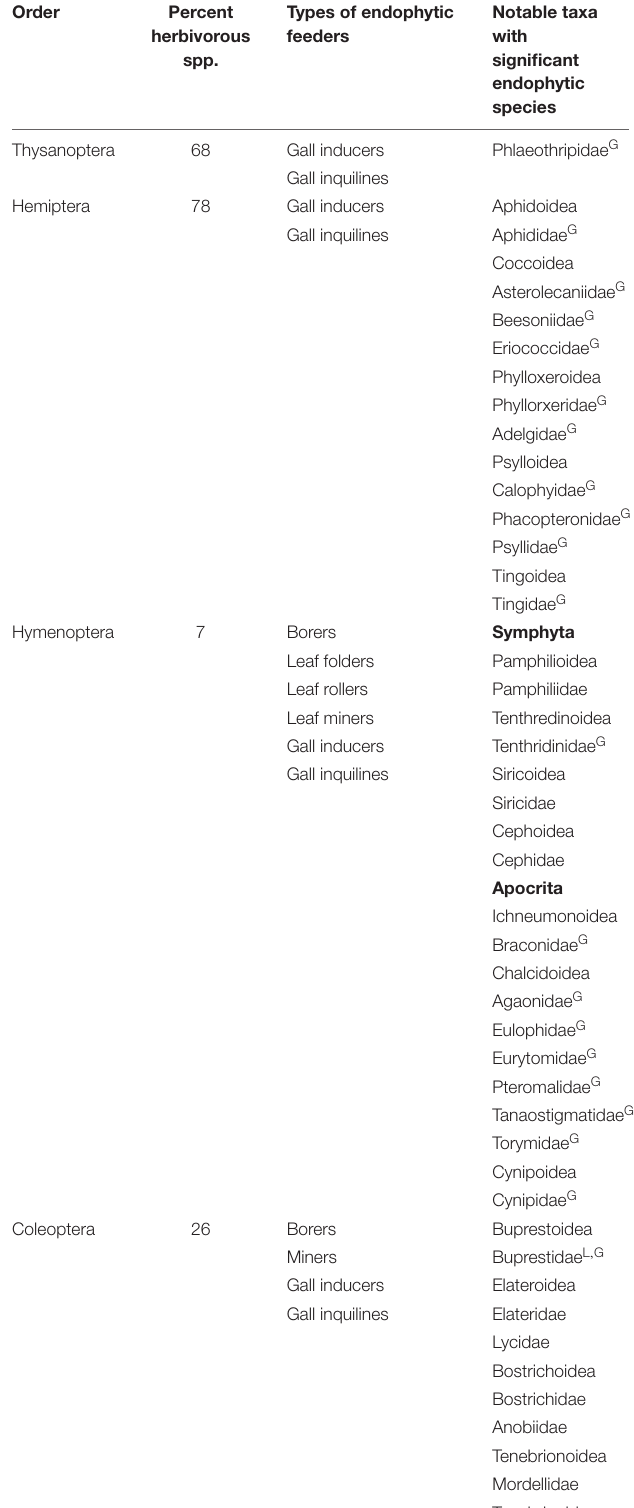
TABLE 1 | Taxa of plant-feeding insects that include significant endophagous